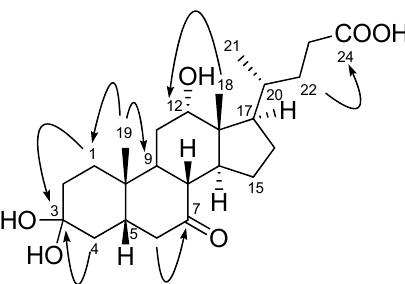
Figure 2. Key HMBC correlations of compound 1